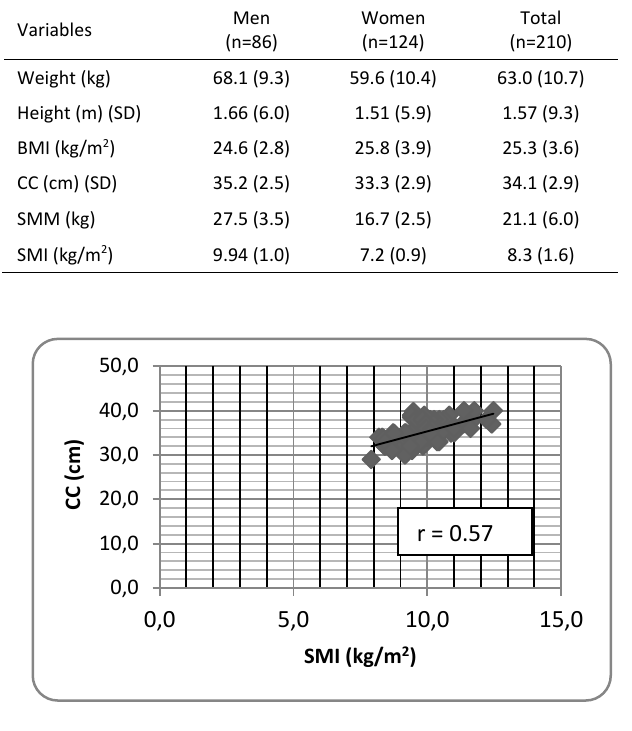
Fig.1: Pearson correlation between calf circumference (CC) and SMI for women.